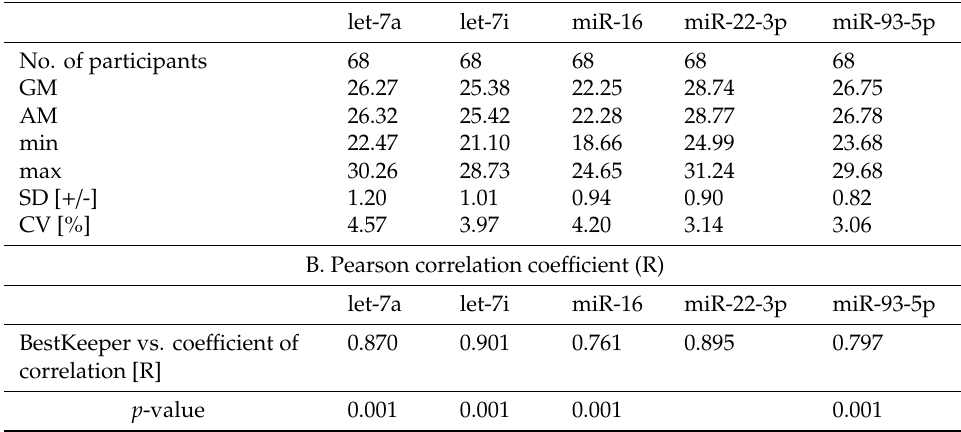
Table 5. Analysis result of reference miRNA performed by Best Keeper application software: ( A ) Crossing Point (CP) values of candidate reference miRNA, where miR-93-5p resulted in the lowest SD (0.82) and Coe ffi cient of Variance (CV) (3.06) values. ( B ) Correlation coe ffi cient (R) result of selected miRNAs.